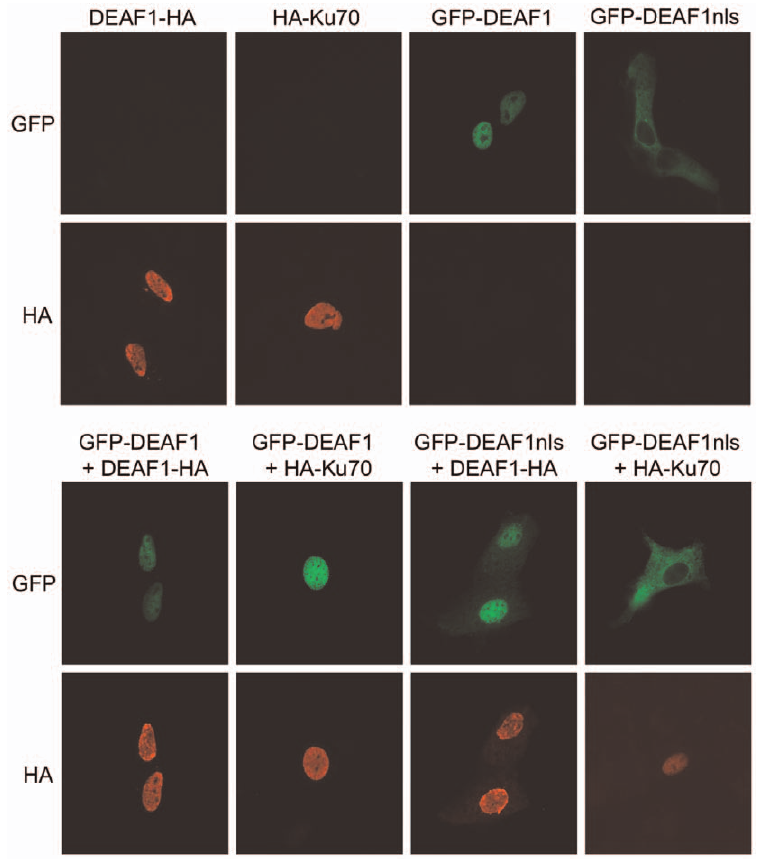
Figure 5. Ku70 is unable to relocalize a cytoplasmic form of DEAF1 to the nucleus. CV-1 cells were transfected either alone or in combinations with DEAF1-HA, HA-Ku70, GFP-DEAF1, or GFP-DEAF1nls (mutated nuclear localization signal). Cellular localization of HA-tagged proteins were determined by indirect immunofluorescence using anti-HA antibodies and secondary antibodies conjugated to CY3 and GFP-tagged proteins were determined by intrinsic GFP fluorescence.